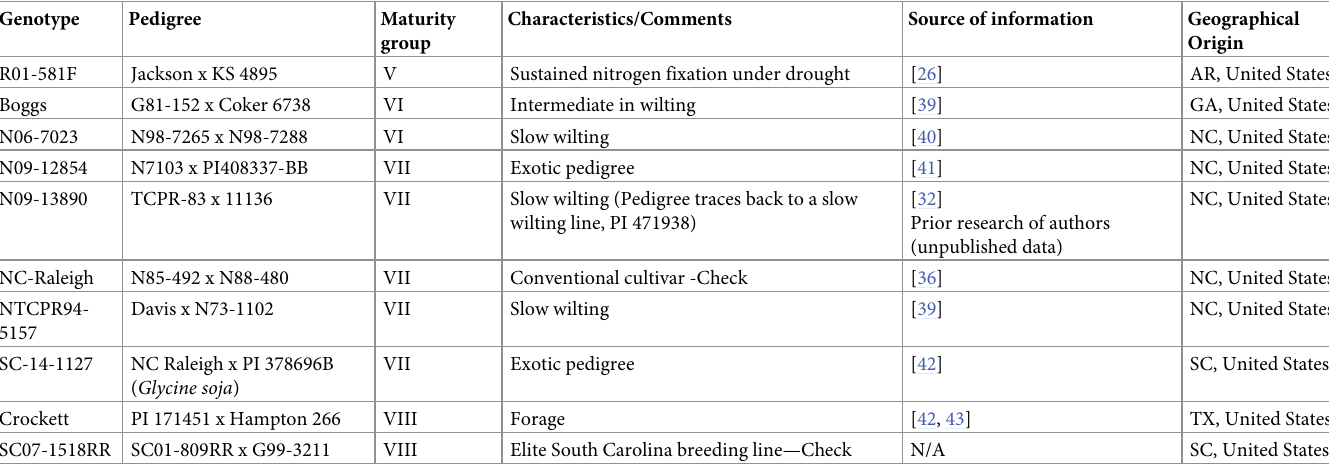
Table 1. Characteristics of the soybean genotypes used in the